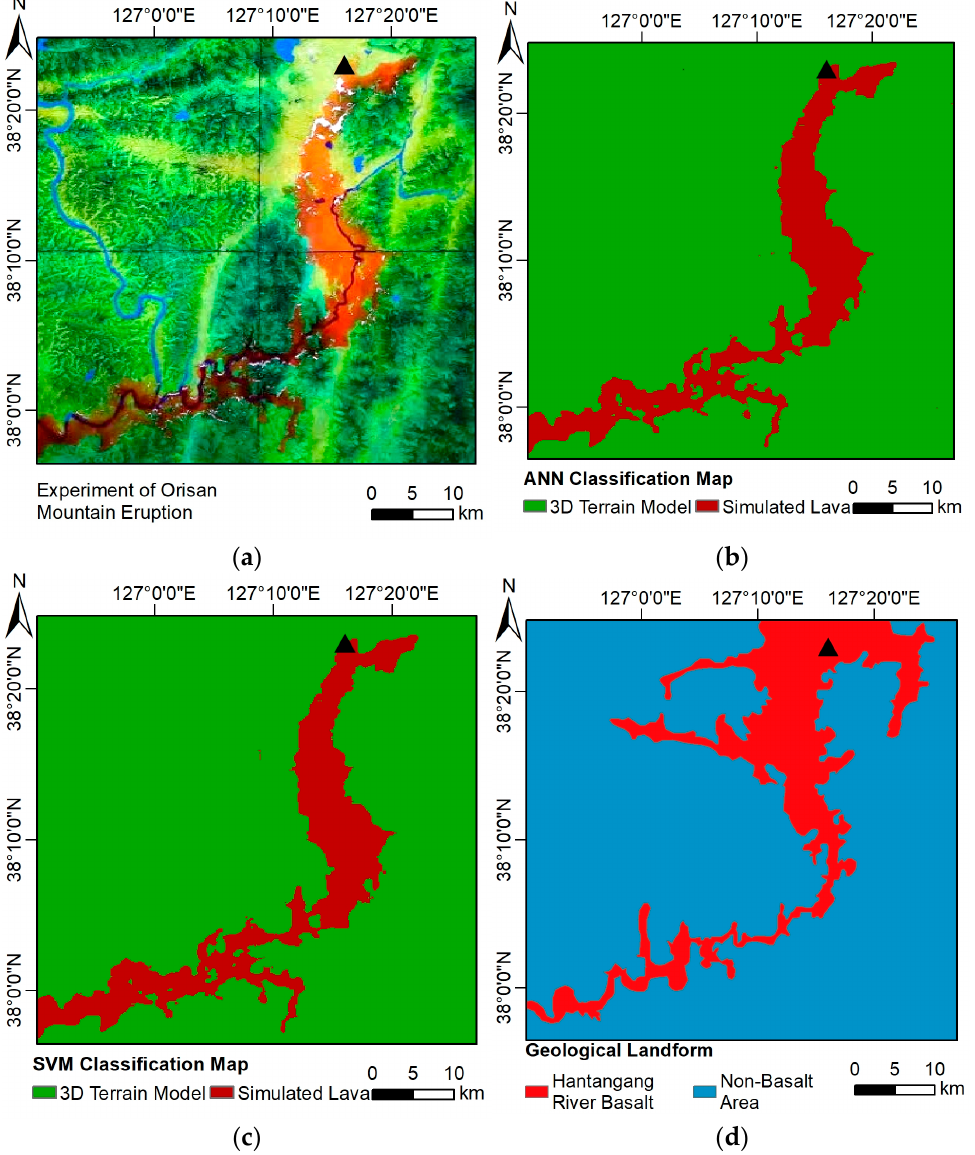
Figure 7. ( a ) Experimental results of the lava flow simulation using the 3D-printed model from the ( b ) ANN classification result and ( c ) SVM classification result. ( d ) Real lava flows from the geological landform of the Hantangang River basalt from the Hantangang River volcanic field.